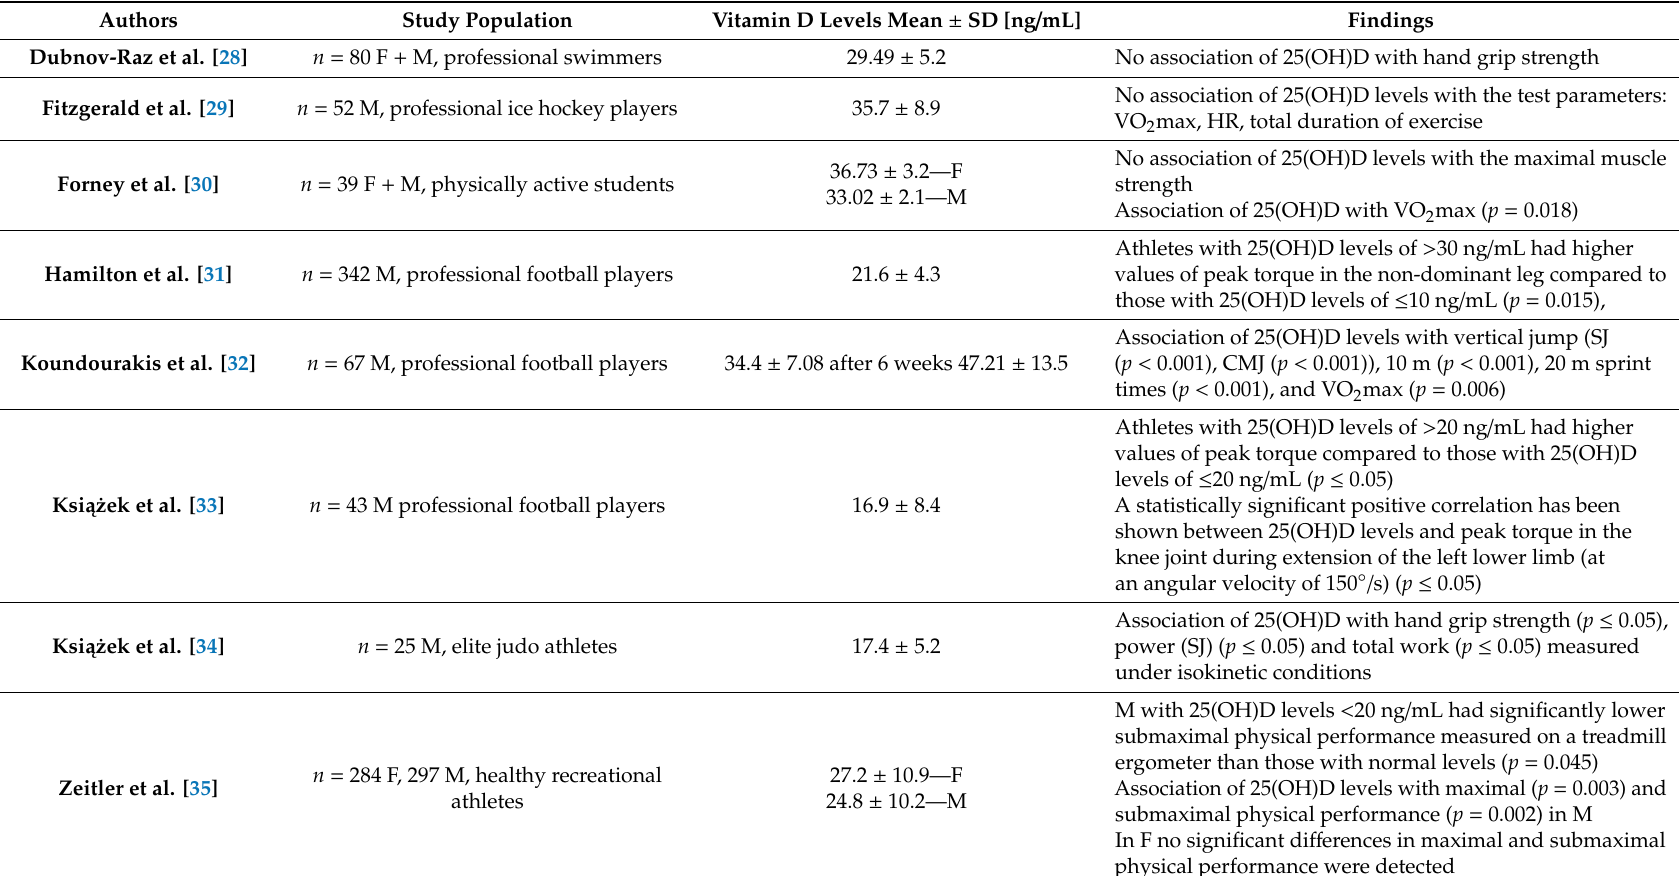
Table 1. Vitamin D, athletic performance and VO 2 max in